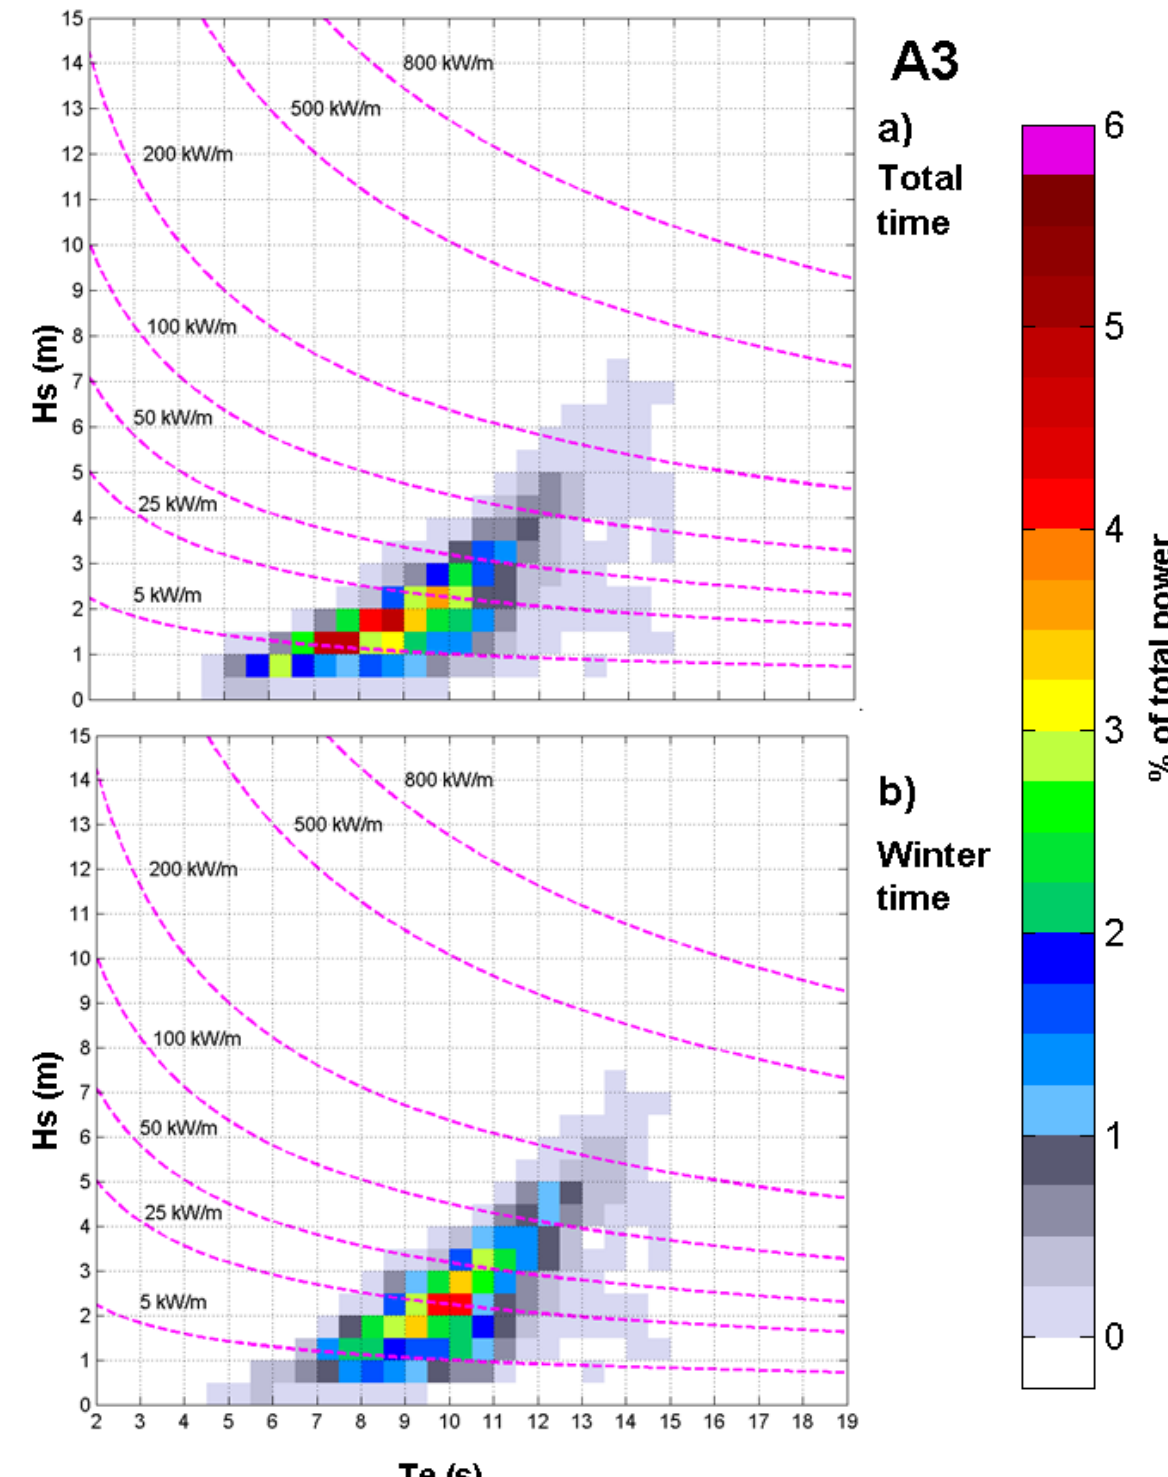
Figure 3. Reference point A3 (P1 offshore); bivariate distributions of occurrences corresponding to the sea states defined by H 2009–2011. The color scale is used to represent the contribution of the sea state to the total incident energy, as a percentage. The wave power isolines are also represented. ( a ) Total time;( b )Winter